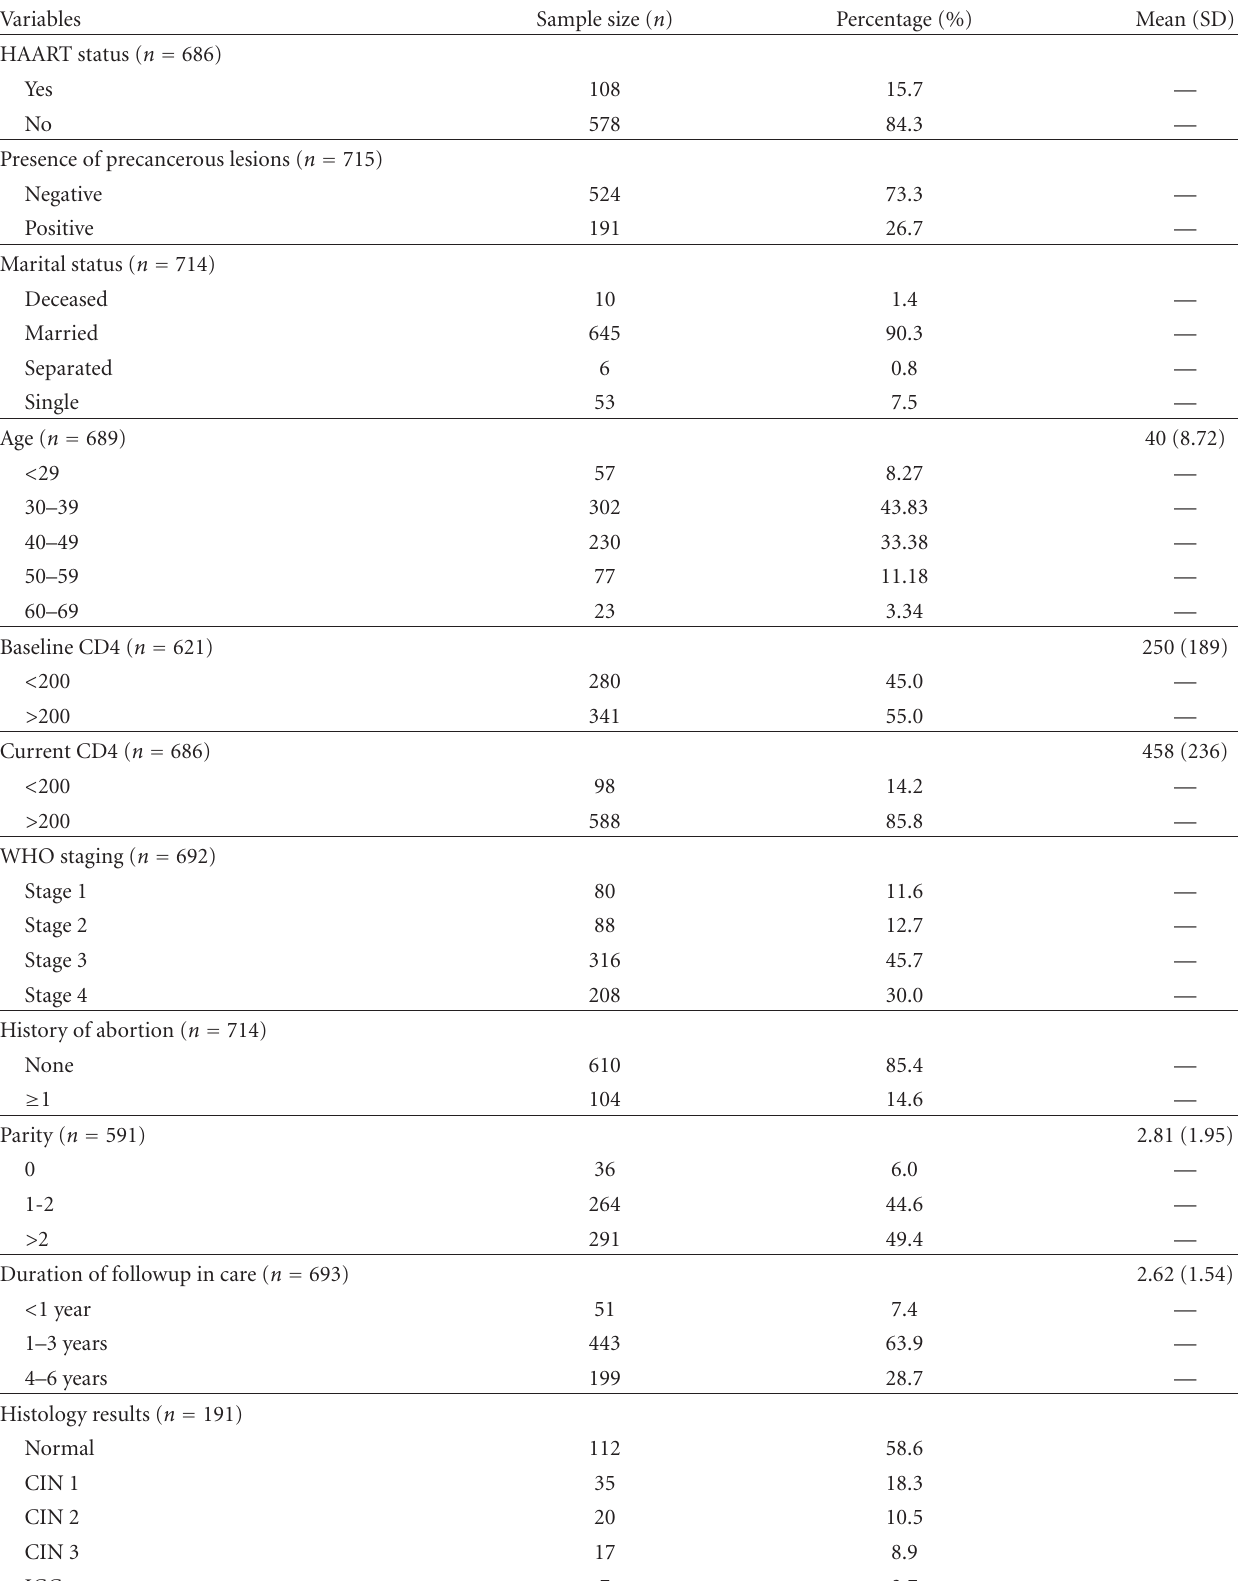
Table 1: Sociodemographic, clinical, and reproductive characteristics of HIV+ women screened for cervical cancer at Nazareth Hospital.